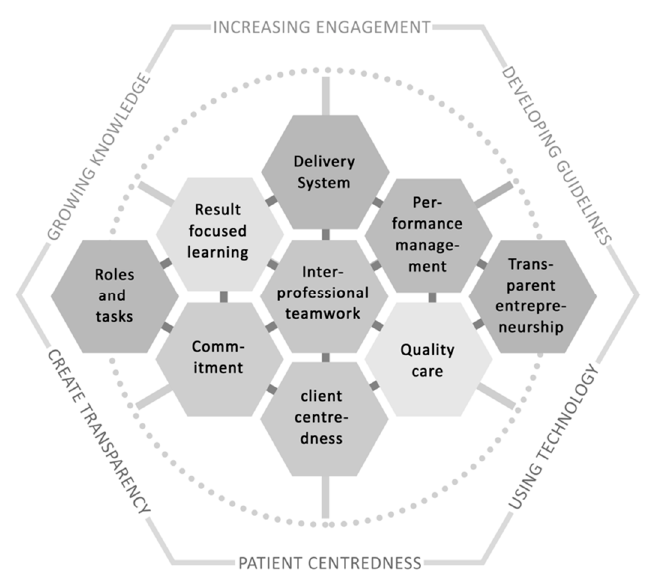
Figure 1. Core Aspects of Integrated Care for Parkinson’s Disease [18,19] .